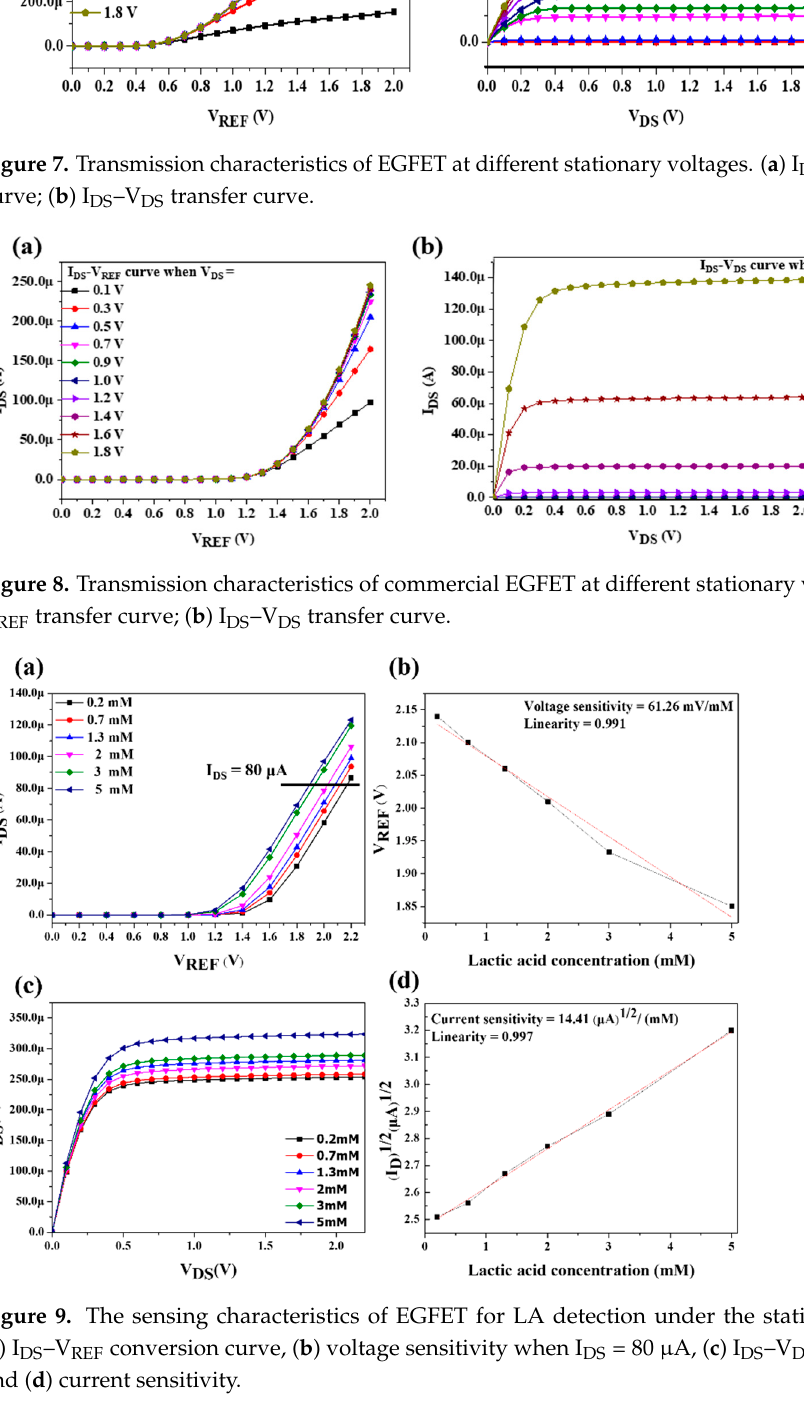
Figure 10. The sensing characteristics of EGFET for LA detection under the dynamic microfluidic measurement. ( a ) I DS –V REF conversion curve, ( b ) voltage sensitivity I DS = 100 μ A, ( c ) I DS –V DS transfer curve, and ( d ) current sensitivity. 3.3. Reproducibility The reproducibility of the RuO 2 LA biosensor was also measured in this study. Re- producibility is the ability of a biosensor to reconfigure to produce the same response ex- periments. Reproducibility is characterized by the accuracy and precision of sensors and electronics in biosensors [41]. A biosensor is considered precise when it gives similar re- sults each time the sample is measured, and it is considered accurate when it provides a value close to the average over multiple measurements of the sample. The reproducibility